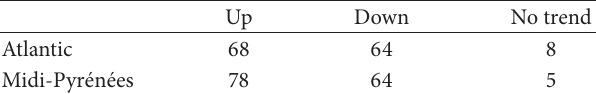
Table 4: Number of stations with positive, negative, and no trends, for number of pads impacted from 1990 to 2010 in the areas with greatest density in Atlantic and Midi-Pyr´en´ees